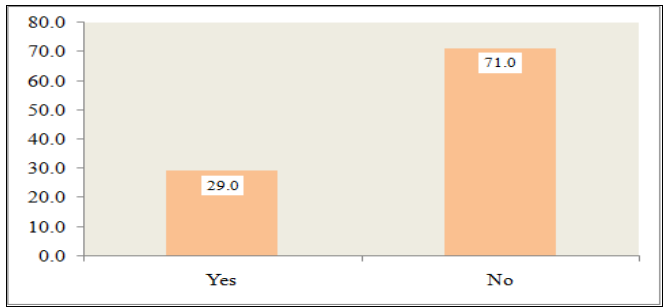
Figure 5: Implementations of Continuing Education Courses on HACCP and Food Hygiene; Source: Author Implementation of HACCP Principles